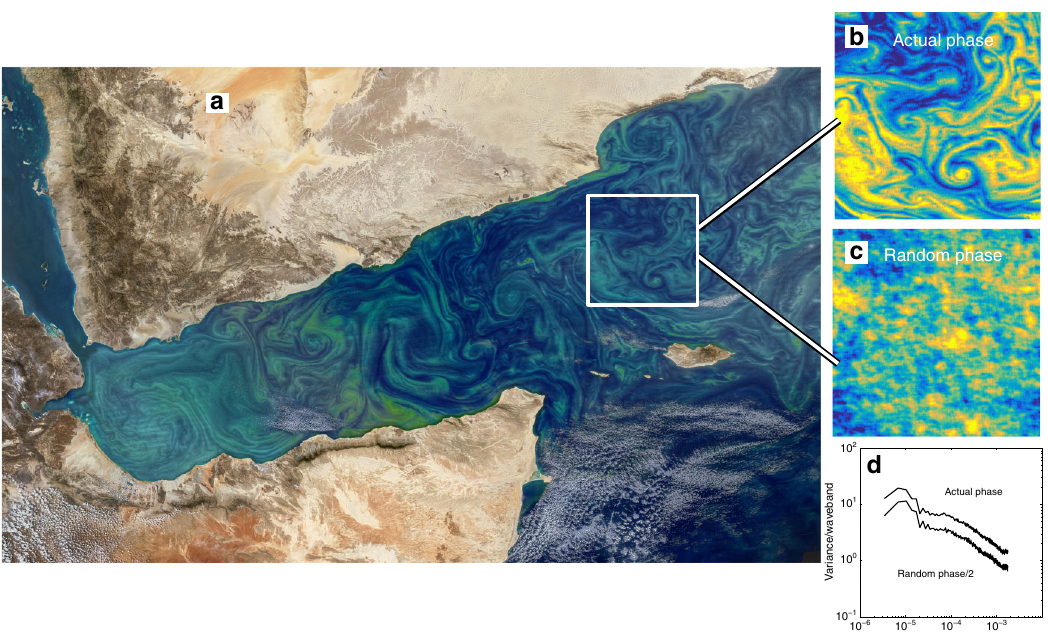
Fig. 1 Surface submesoscale phytoplankton patchiness. a An image of the Gulf of Aden acquired Febuary 12, 2018 by the MODIS system on NASA ’ s Aqua satellite (250 m horizontal resolution), showing swirling and fi lamentary patterns of ocean chlorophyll (Image credit: NASA Earth Observatory) . b A false- color rendering of the data from the 200 × 200 km box indicated in a . c A false-color rendering of the data obtained from a two-dimensional inverse Fourier transform of the spatial spectrum from panel b , but with a randomized phase. The median radial spatial spectra of b and c are shown in d , where the spectrum from d has been divided by 2 to make it visible: the two spectra are statistically identical. It is clear that the coherent phytoplankton patches in a and b are a consequence of the phase relationships among the Fourier components making up the spectrum, rather than the relative magnitudes of the Fourier components (the spectral slope). Panels b and c have identical variability — their spectra are the same, but the patchiness in b forms coherent structures while it is random in